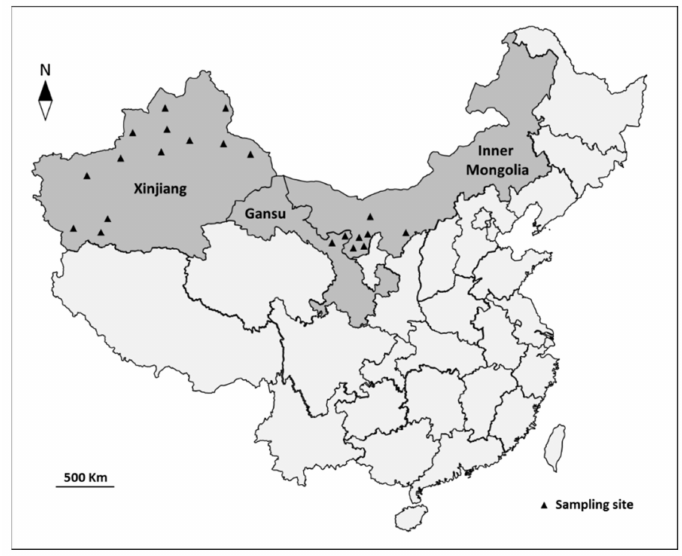
Figure 1. Geographical distribution of sampling sites in the present study. Each black triangle represents one sampling